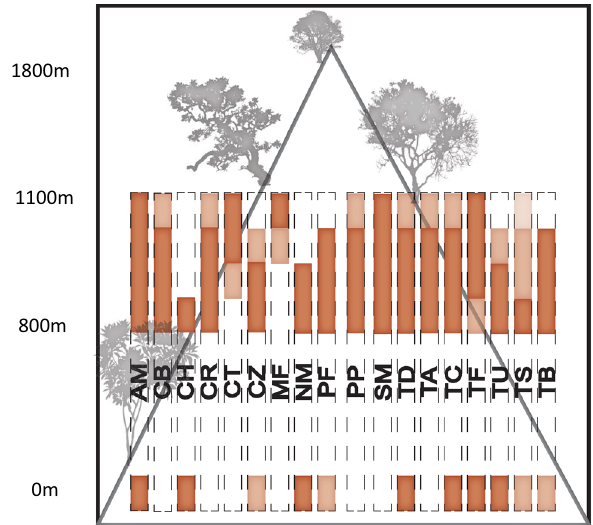
Figure 2. Abundance by elevation of 18 bee species collected in Northwestern Costa Rica. Darker brown indicates a statistically higher abundance for that bee species, with each elevation sampled comprising one- fourth of the bar from 800-1100 m elevation. Bee abundance differences were not statistically assessed between 800 and 0 m elevation since collection methods differed. Dark brown at 0 m elevation indicates a similar or higher abundance to 800 m, lighter brown indicates a lower abundance compared to 800 m. White blocks for an elevation band indicate that no individuals were collected for that bee species at that elevation. Apis mellifera (AM) and Scaptotrigona mexicana (SM) are included as bee species that did not statistically differ in abundance by elevation, and Ceratina chloris (CH) is included as one species that was not collected in sufficient numbers to statistically test, but was found in high numbers at 0 m elevation and only collected from 800 m elevation in the mountains.